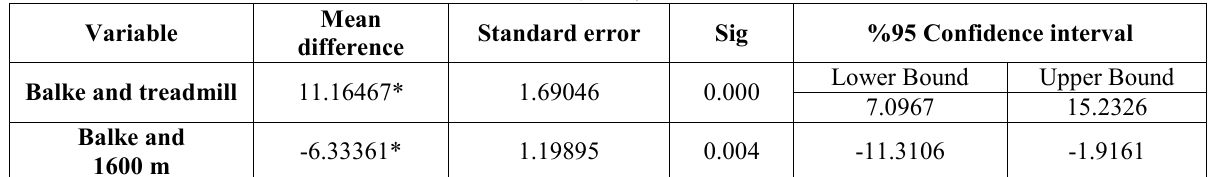
Table 4. Results of LSD test to compare the treadmill test with average VO2max in the 1600 m and Balke